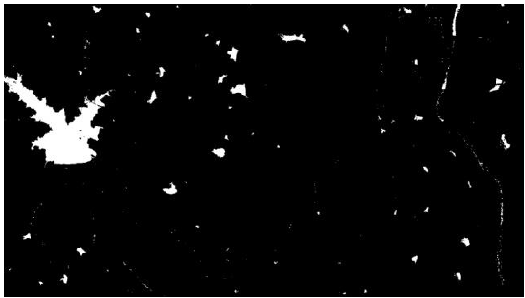
Figure 12: MNDWI Paleru reservoir with canal